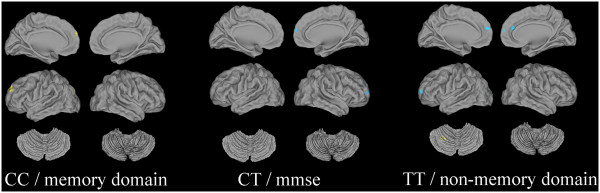
Correlations between ALFF and neuropsychological tests. Thresholds were set at a corrected P <0.05, determined by Monte Carlo stimulation (yellow: positive correlation; blue: negative correlation).